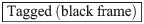
Localization of SMARCAL1 mutations detected in 34 subjects with Schimke immuno-osseous dysplasia.Legend: Tagged (black frame): recurrent mutations detected in at least three unrelated patients; Green font: novel mutations described for the first time in the current study. Reference sequence: ENST00000357276; NM_014140.